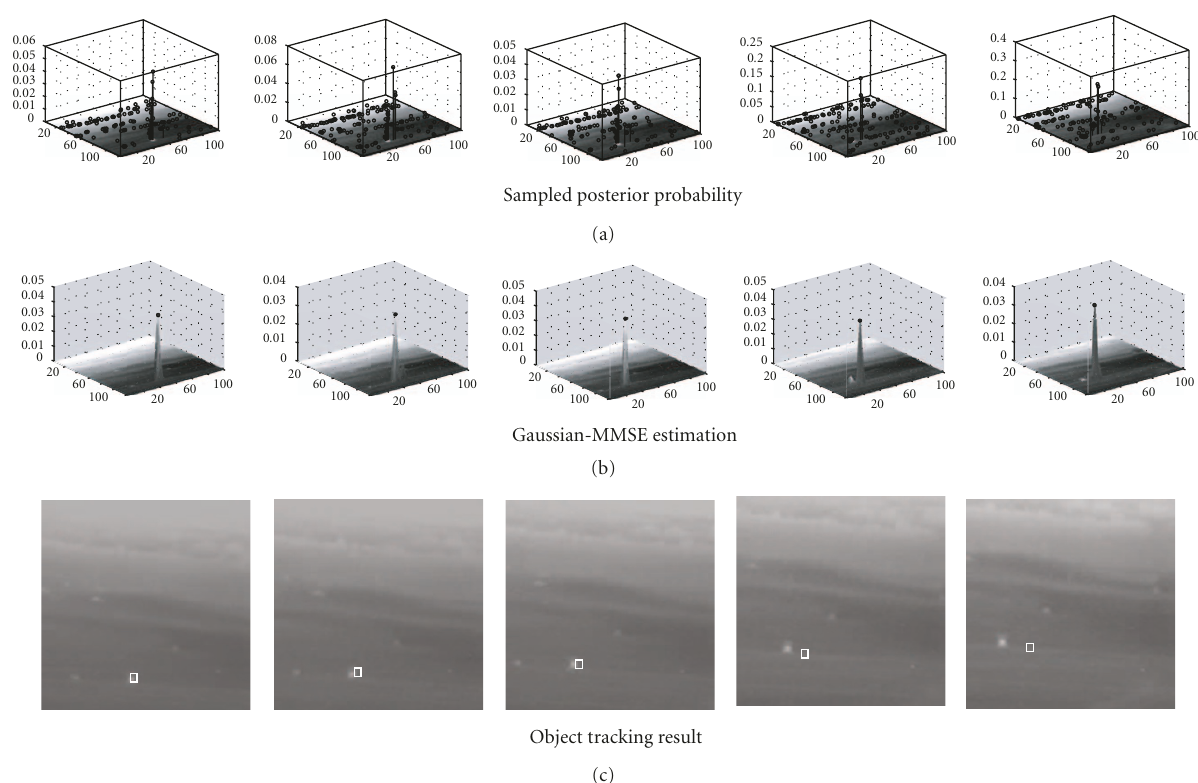
Figure 18: Tracking results for the NEH algorithm in a situation where the ego-motion compensation is especially challenging due to the aperture